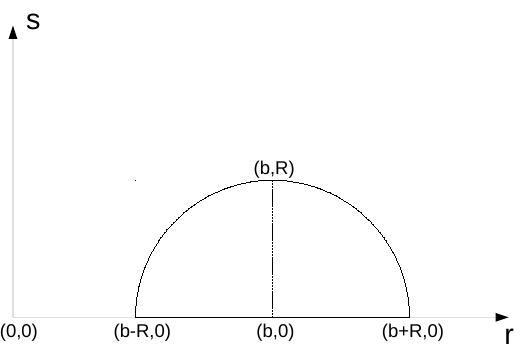
Figure 2 . s vs. r plot for a black ring with S D − 3 radius R ( b > R